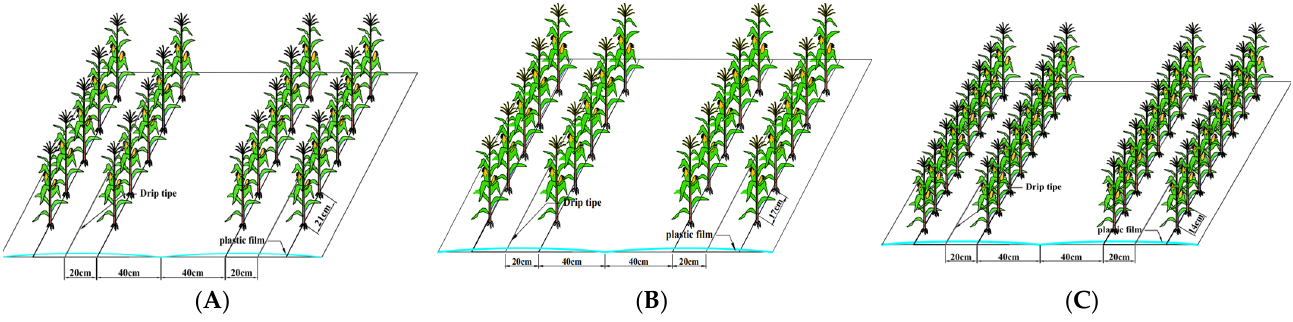
Figure 1. The schematic diagram of maize planting pattern with 80 cm wide and 40 cm narrow rows. ( A ) D1: 80,000 plants ha − 1 , with plant spacing of 21 cm; ( B ) D2: 100,000 plants ha − 1 , with plant spacing of 17 cm; ( C ) D3: 120,000 plants ha − 1 , with plant spacing of 14 cm.